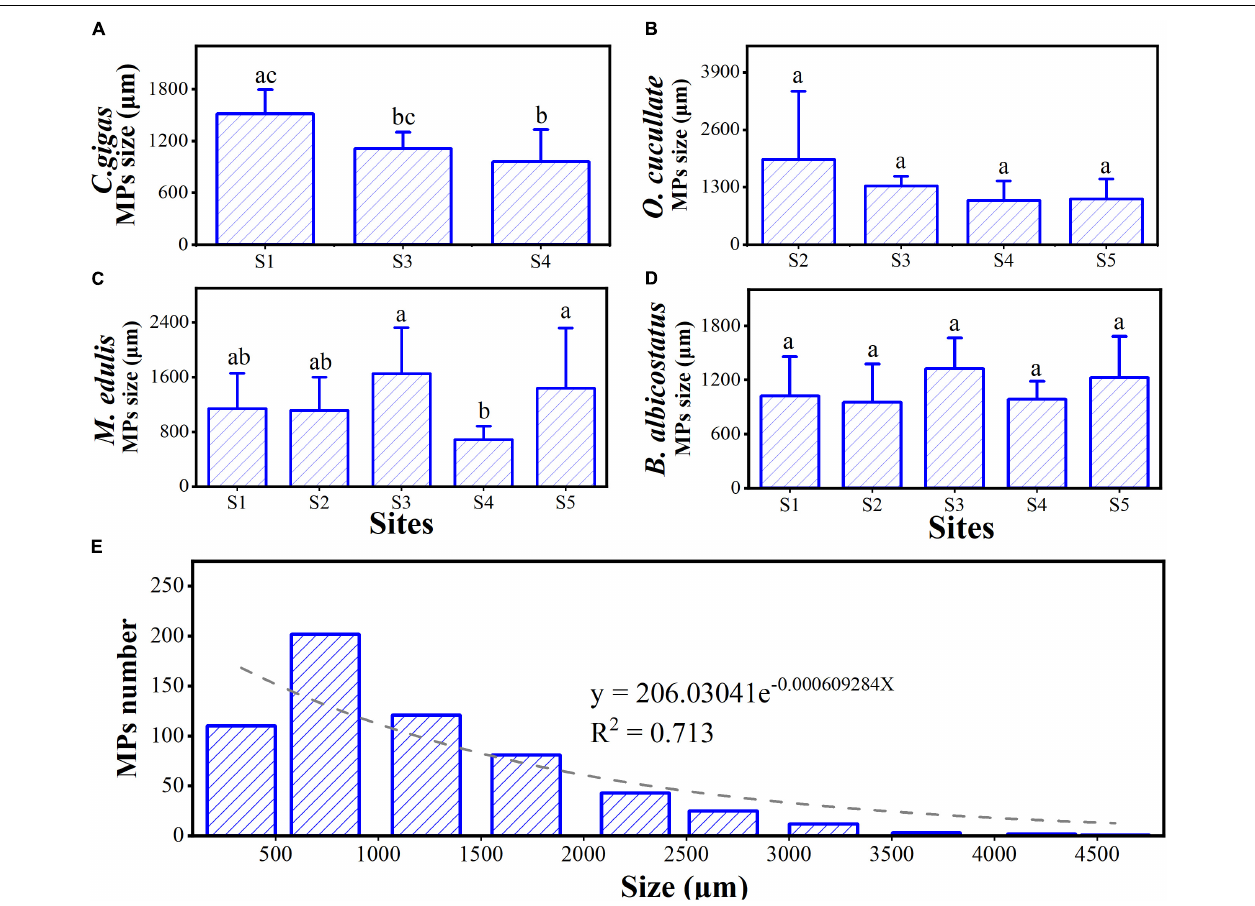
FIGURE 6 | Mean MP size ( ± SD) in four species of barnacles and wild bivalves from different sites (A–D) in the Yellow Sea and the size distribution of the MPs in all wild bivalves and barnacle samples (E) . Different letters above the bars indicate significant differences among species (one-way ANOVA, P < 0.05). The gray dashed represents the fit between the number and the particle size of